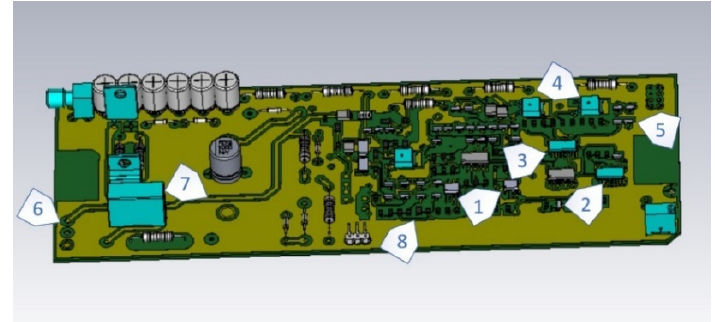
Figure 7. Eight probe positions.